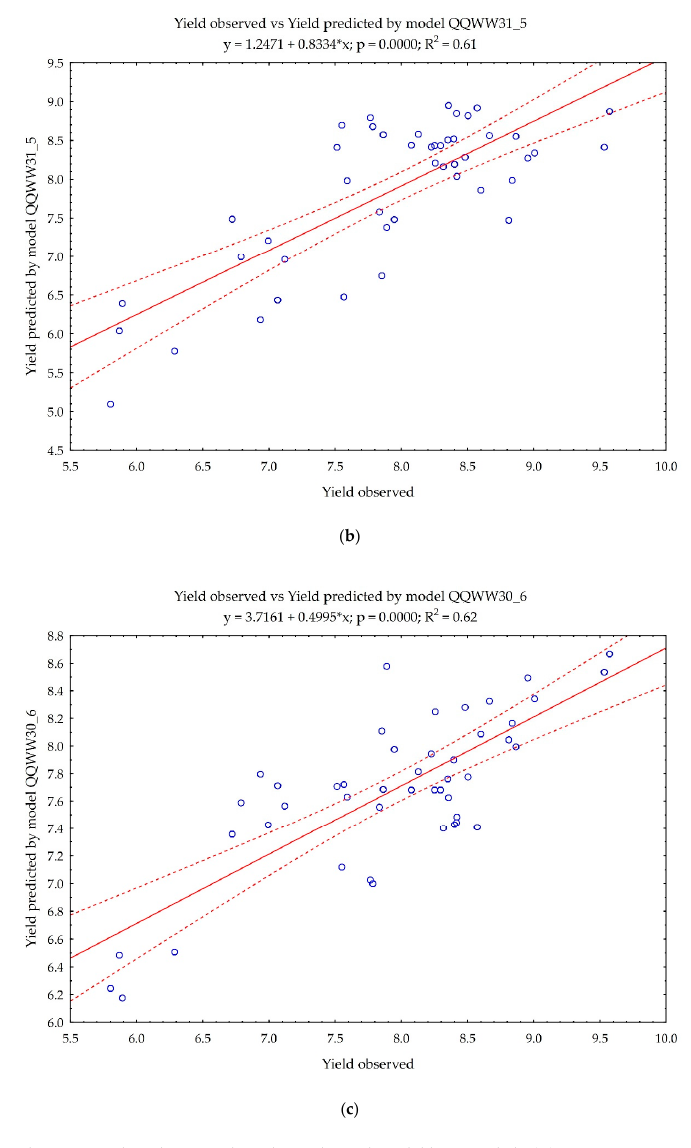
Figure4. Relationbetweentheobservedandpredictedyieldbymodel: ( a )QQWW15_4, ( b )QQWW31_5, and ( c )